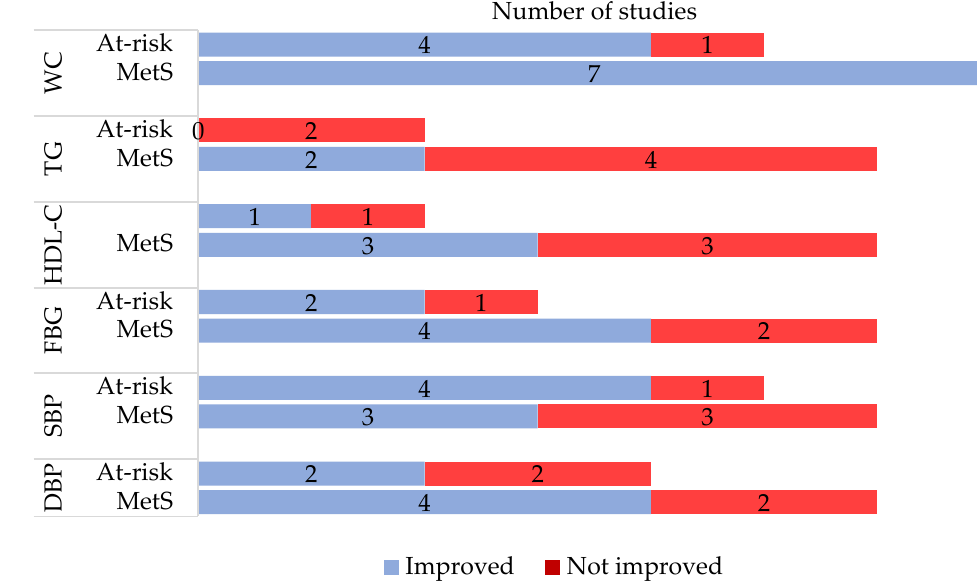
Figure 2. Metabolic syndrome-related outcomes as reported in the included studies. MetS = metabolic syndrome; WC = waist circumference; TG = triglyceride; HDL-C = high-density lipoprotein cholesterol; FBG = fasting blood glucose; SBP = systolic blood pressure; DBP = diastolic blood pressure